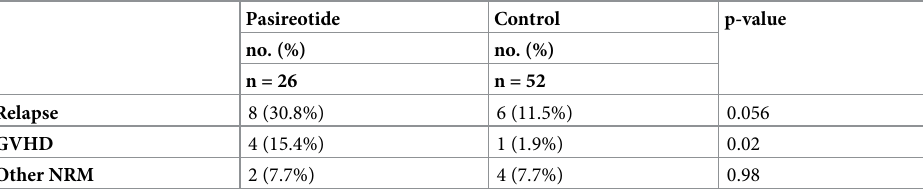
Table 3. Summary of cause of death. NRM- non-relapse mortality.